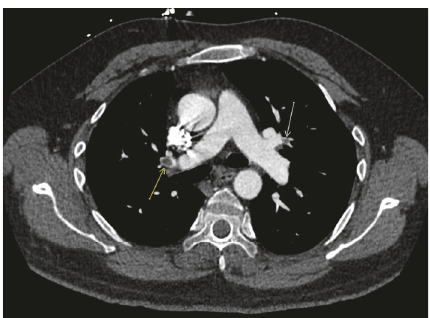
Figure 1: Axial CT image of the chest at the level of the main pulmonary artery bifurcation. Arrows denote two of the multiple pulmonaryarteryemboli(fillingdefects)whichwereobservedbilat- erally in this patient within both lobar and segmental pulmonary arteries.